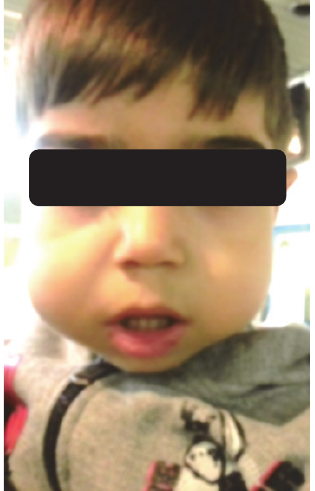
Figure 1: Swelling of the patient’s jaws.